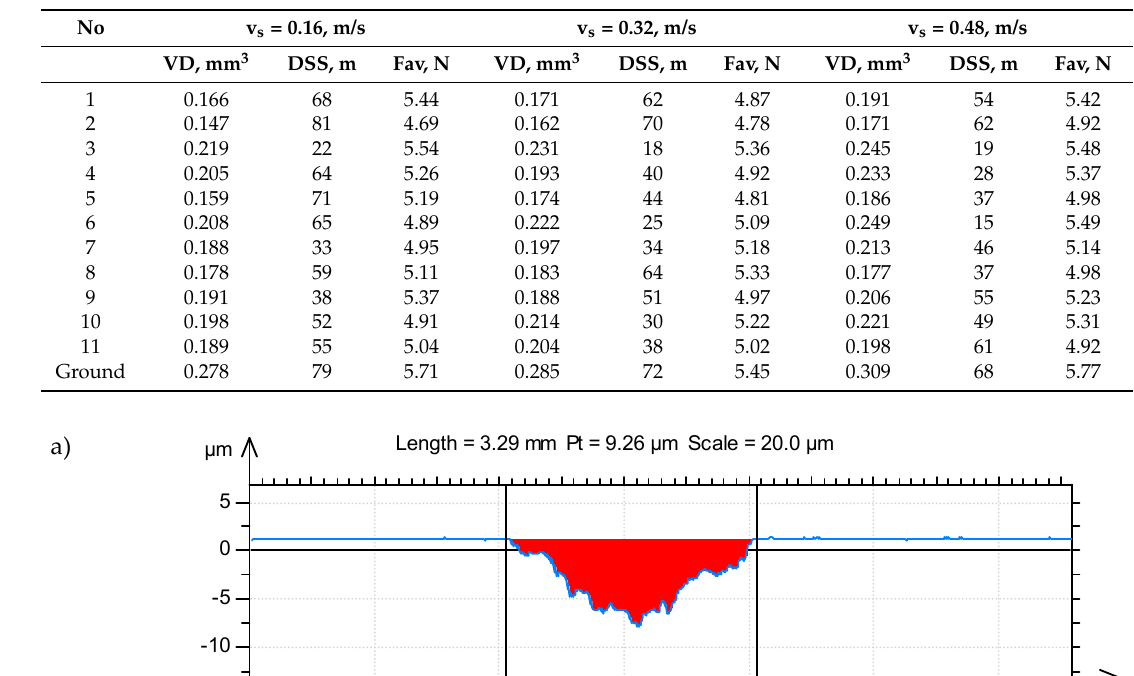
Table 4. Results of the tribological tests. VD: Mean value of the volumetric wear of the disc samples. DSS: Sliding distance after which the friction force obtains steady-state conditions. Fav: Average value of the friction force after obtaining the steady-state condition.